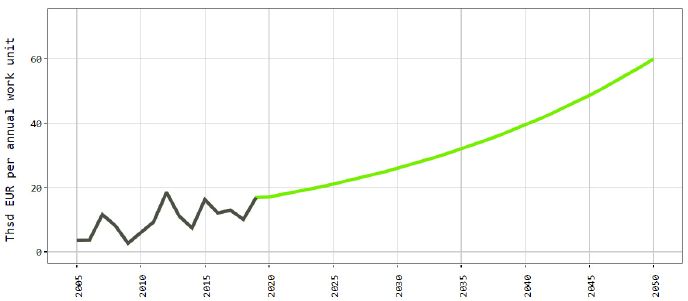
Figure 22. Value added per employed in specialized field crop farms in 2005–2019, and a 2020–2050 projection for Latvia, in thousands of EUR [62].